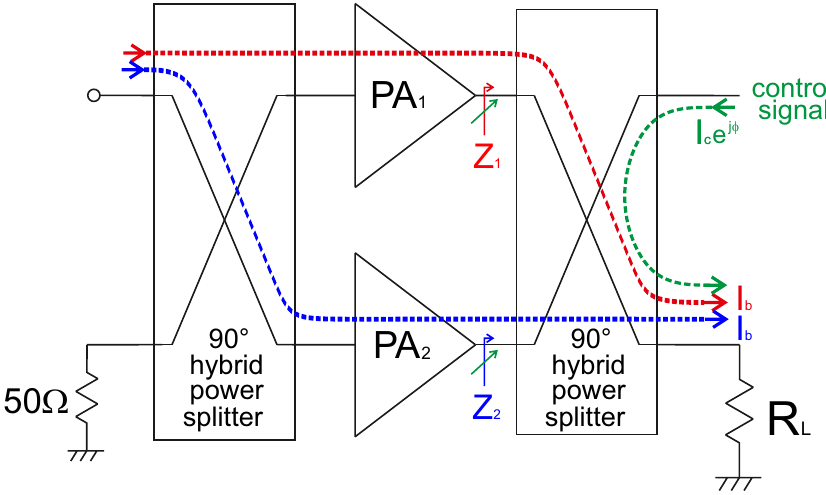
Figure 19. Load Modulated Balanced PA (LMBA) scheme.